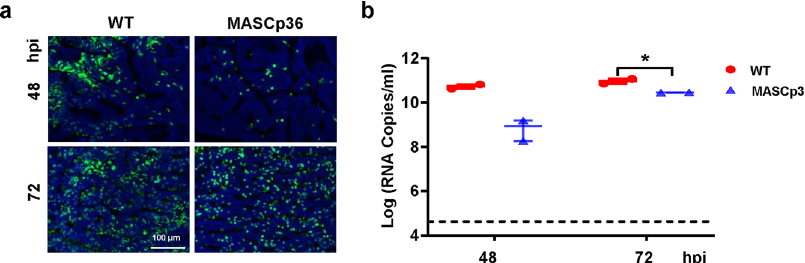
Fig. 9 Characterization of MASCp6 and MASCp36 in human airway epithelial (HAE) cells. a Immuno fl uorescence staining of WT and MASCp36- infected HAE cultures for SARS-CoV-2 N protein (green) and DAPI (blue) at 48 and 72 h post infection. The percentage of SARS-CoV-2 N protein positive cells is presented as mean ± SD ( n = 4). b Growth kinetics of WT (BetaCoV/Beijing/IMEBJ05/2020, Nos. GWHACBB01000000) and MASCp36 in HAE at 48 and 72 h post infection. Results are shown as mean ± SD from two independent replicates. The exact P values of 48 and 72 h post infection were 0.0905 and 0.0455 analyzed by two-way ANOVA.